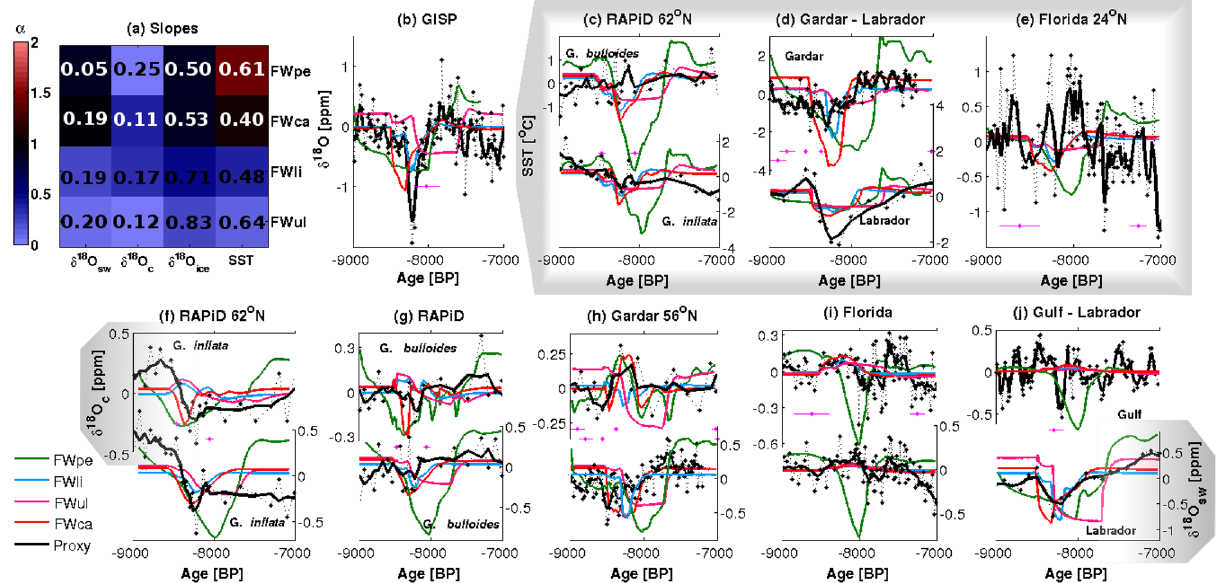
Figure 1. Comparison between time series of proxies and simulations for δ 18 O sw , δ 18 O ice , δ 18 O c and SST for RAPiD ( c , g ), Gardar Drift ( d , h ), Florida Strait ( e , i ), GISP and Gulf cores ( b , j ), and slopes and RMSEs ( a ) in all simulations (locations in Fig. S1 and Table S1). Black dashed and full lines are core values and 2-point moving averages, respectively. Green, blue, magenta and red lines are time series for FWpe, FWli, FWul and FWca. The pink horizontal crosses are the dating ( ) and dating errors ( ) for the proxies. In ( a ) RMSE values are plotted in the center of the image while the colors of the squares indicate the values of the slopes . From ( f – j ), top series are for δ 18 O c , while bottom series are for δ 18 O sw